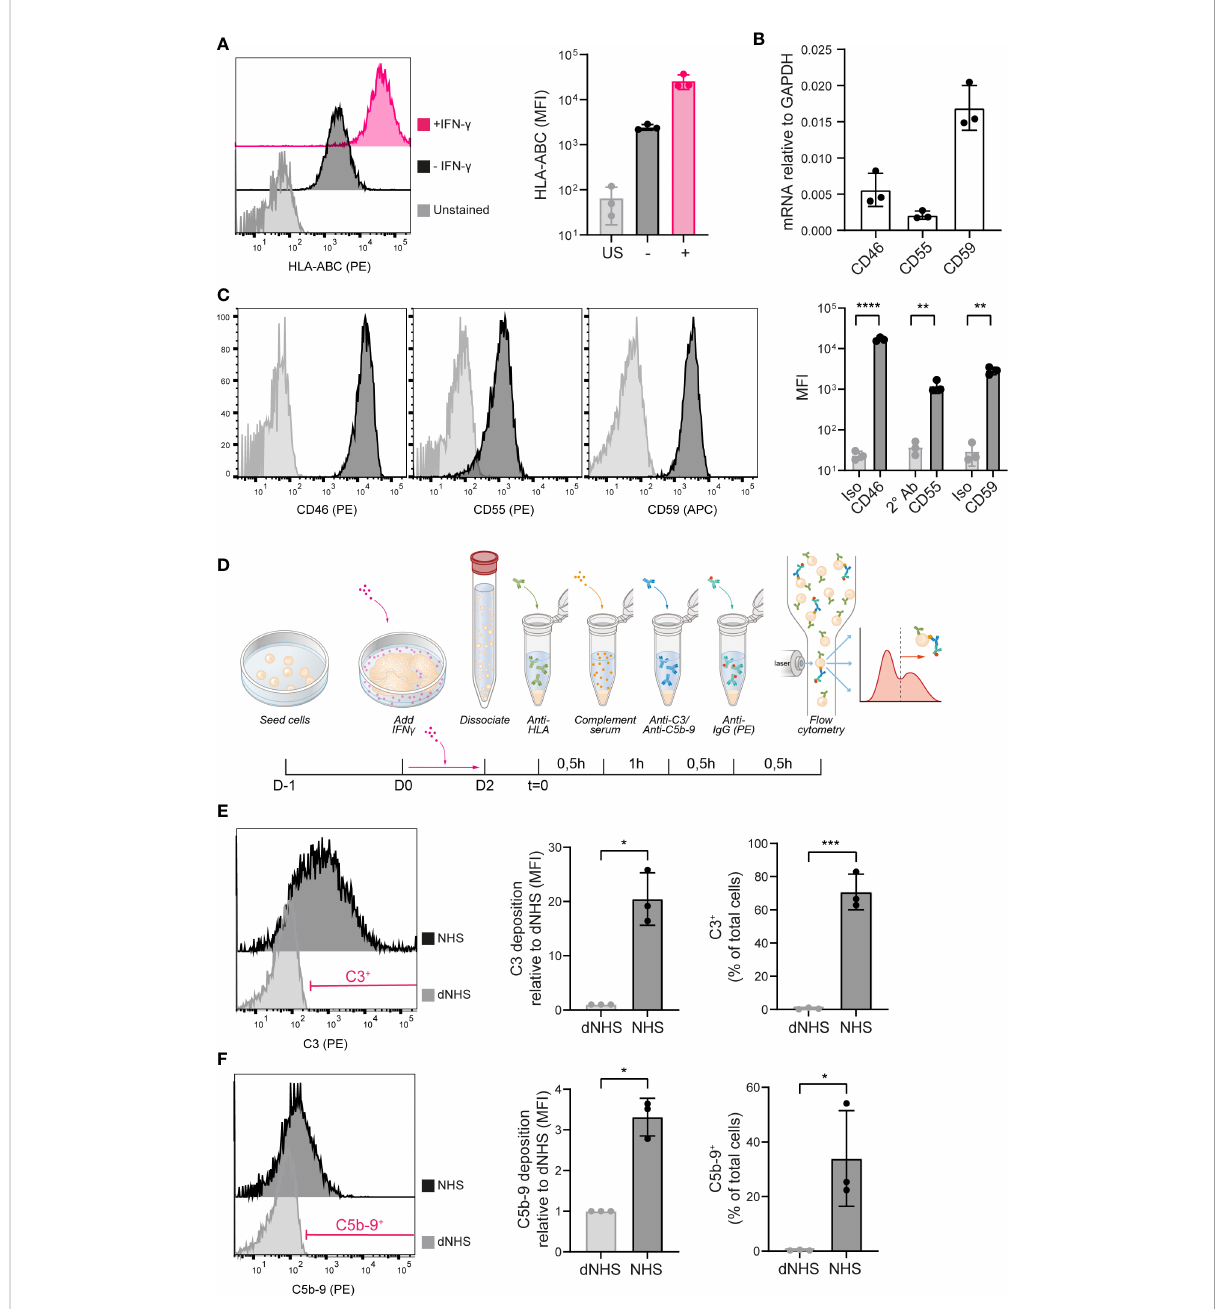
FIGURE 1 iPSCs are vulnerable to complement activation. (A) HLA-ABC surface protein expression measured by fl ow cytometry in unstained (US), unstimulated ( – ) and IFN- g stimulated (+) iPSCs. A representative histogram is shown of three independent experiments (n=3). (B) mRNA expression of CD46, CD55 and CD59 in iPSCs measured by RT-qPCR (n=3). (C) Complement inhibitor CD46, CD55 and CD59 protein surface expression in iPSCs measured by fl ow cytometry. Representative histograms are shown of three independent experiments (n=3). (D) Schematic of the experimental procedure to measure complement deposition on iPSCs in vitro . (E) C3 deposition on iPSCs incubated with heat-inactivated (dNHS) or active normal human serum (NHS) measured by fl ow cytometry. Results are presented as relative mean fl uorescence intensity (MFI) and C3 + proportion. A representative histogram of three independent experiments (n=3) is shown and indicates the gate for the C3 + proportion. (F) C5b-9 deposition on iPSCs incubated with heat-inactivated (dNHS) or active normal human serum (NHS) measured by fl ow cytometry. Results are presented as relative mean fl uorescence intensity (MFI) and C5b-9 + proportion. A representative histogram of three independent experiments (n=3) is shown and indicates the gate for the C5b-9 + proportion. Error bars show standard deviation and signi fi cance (*p < 0.05; **p < 0.01; ***p < 0.001; ****p < 0.0001) was evaluated using